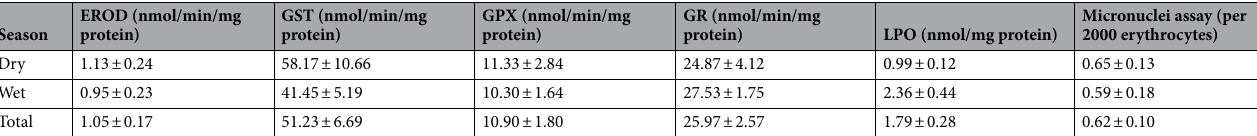
Table 2. Hepatic ethoxyresorufin O -deethylase (EROD), glutathione S -transferase (GST), glutathione peroxidase (GPX), glutathione reductase (GR), lipid peroxidation (LPO) and micronuclei assay in